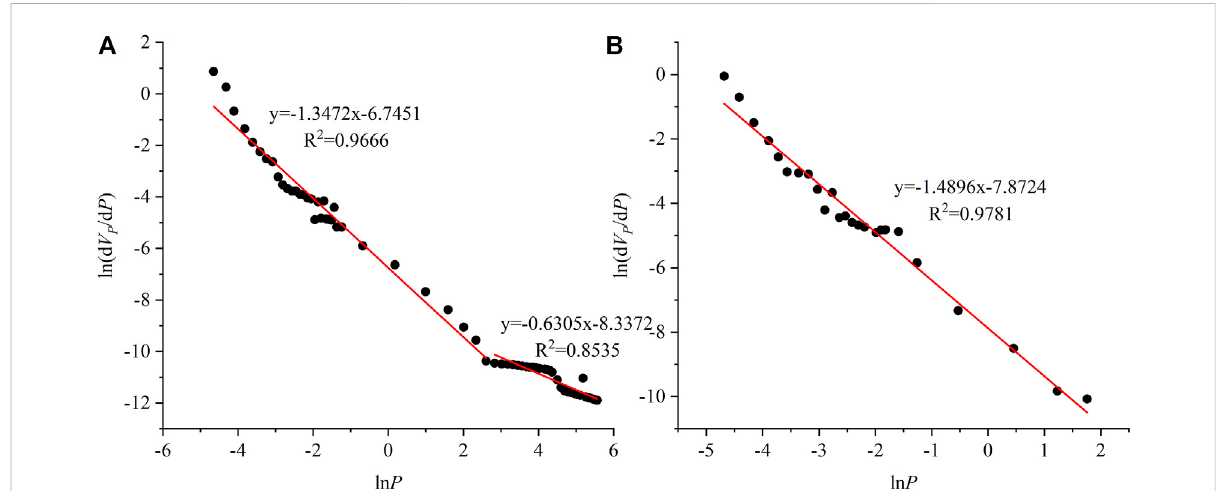
FIGURE 7 Fractal calculation results from ln (d V P /d P ) vs. ln P reconstructed from MIP for two representative shale samples (A) sample 3; (B) sample 9.